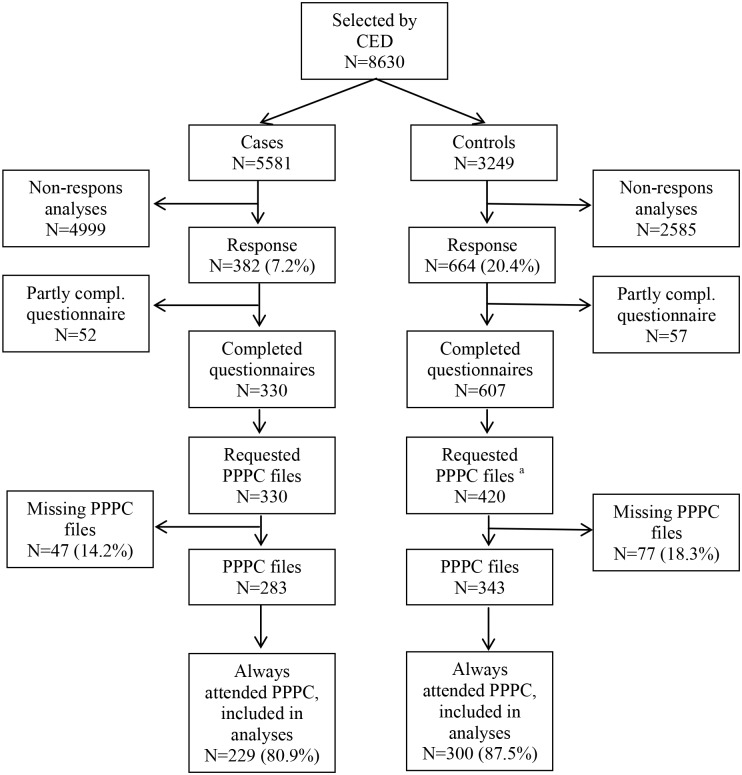
Flowchart of participant selection for the analyses.Abbreviations::CED compulsory educational department, PPPC preventive pediatric primary care, Compl. Completed. a randomly selected.